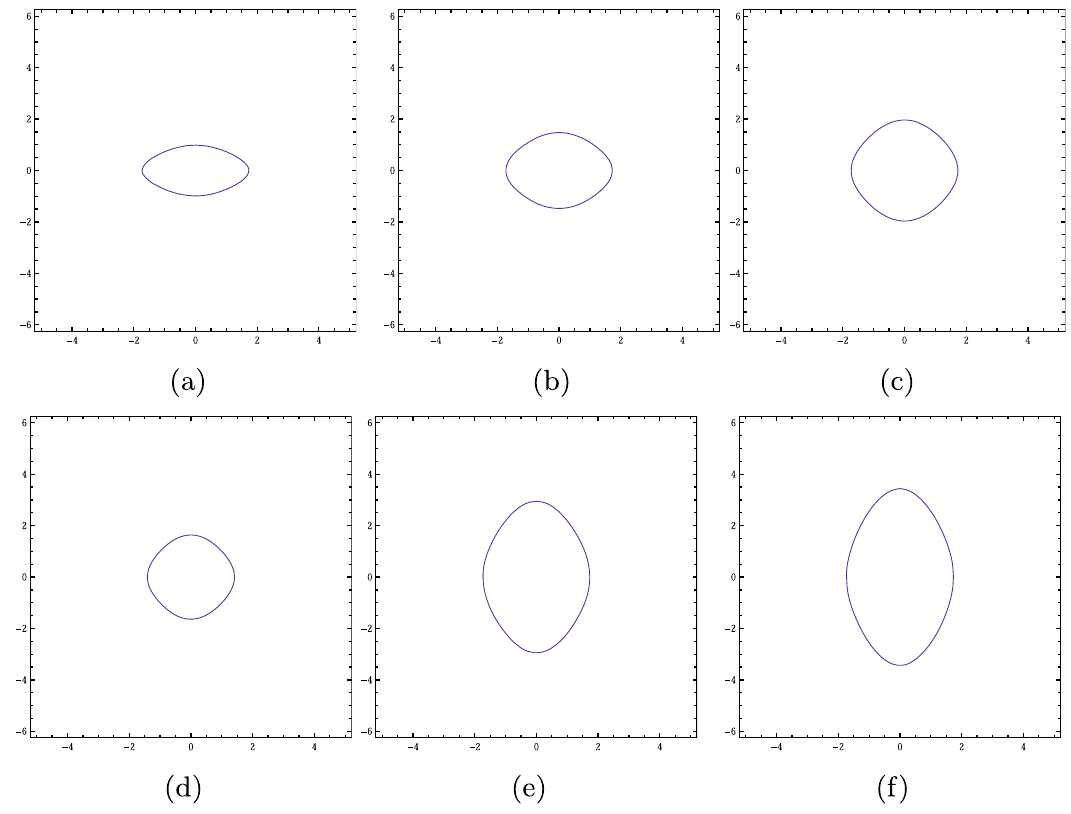
Figure 5: The shape of metric ball ( ) δ x x , t 1 2 when we fi x = t 0.75 , = a 1 and b changes from 1 to 3.5 in the interval of 0.5.